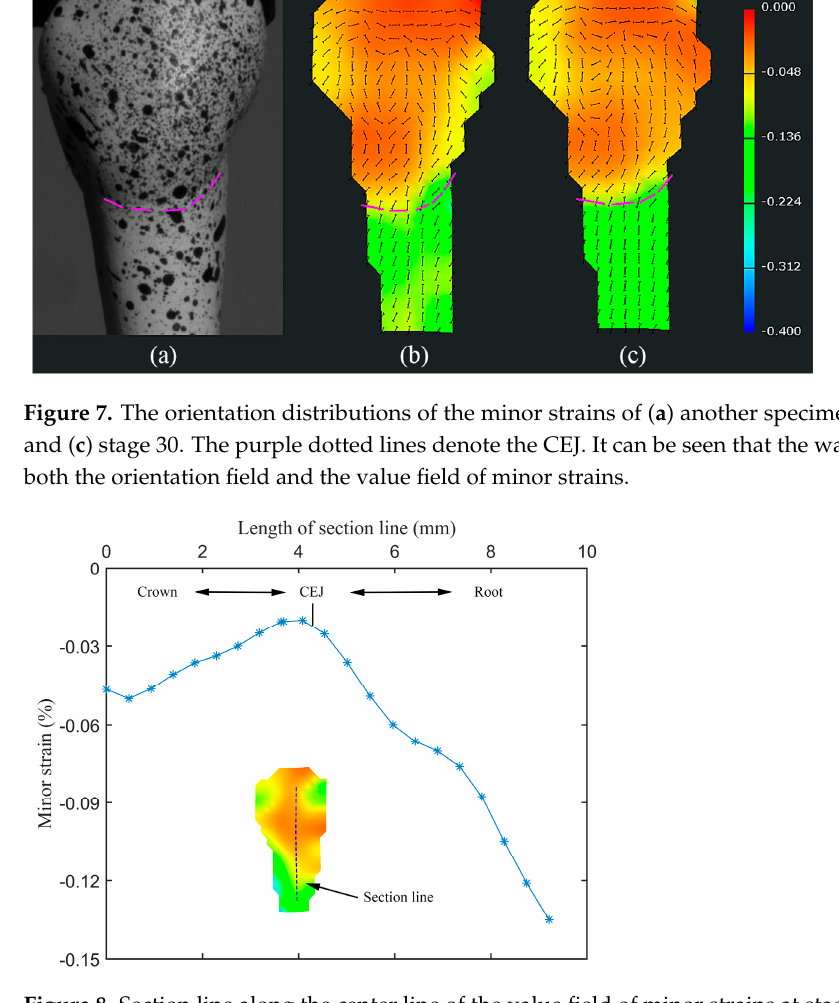
Figure 8. Section line along the center line of the value field of minor strains at stage 39 in Figure 4.